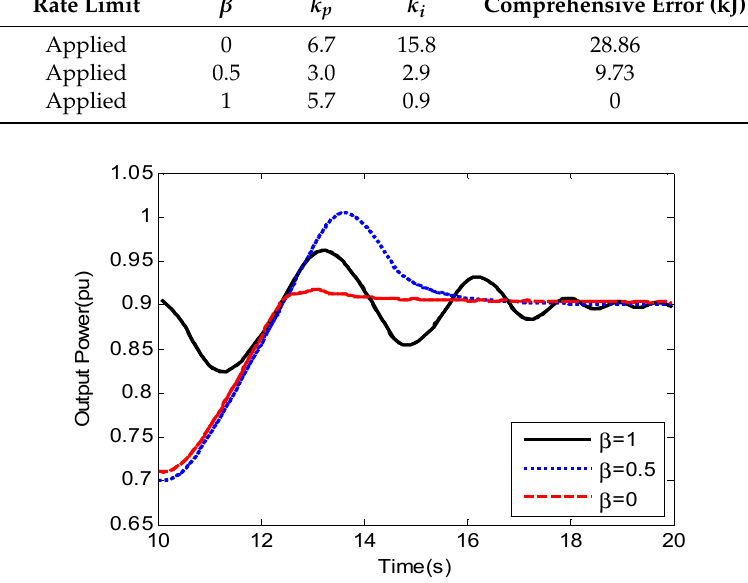
Table 5. Optimization results under different error weights.